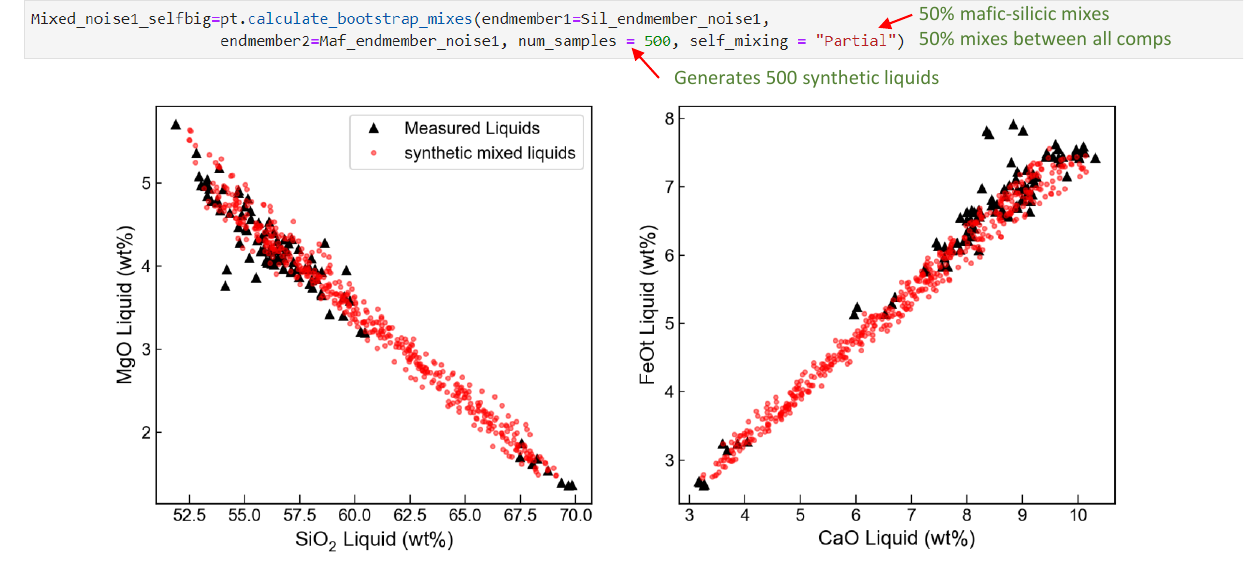
Figure 5: Example of functions allowing users to generate synthetic liquids, adapted from the approach of Scruggs and Putirka [2018]. Step 1 : The user reads in all measured Liq compositions into one pandas dataframe (MyLiquids1), and all Cpx into a second dataframe (myCpxs1). Step 2 : Using as many compositional filters as required, the user defines 2 end-members. Step 3 : These end-members are then mixed to generate 500 synthetic liquids which incorporate the variation in the natural